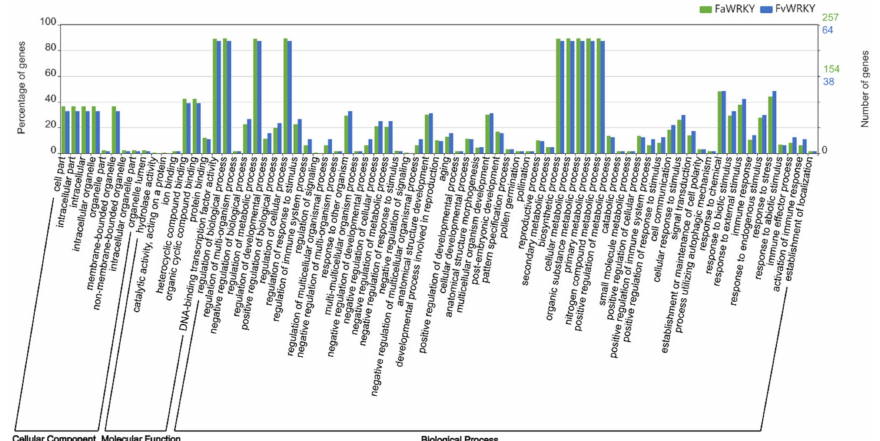
Figure 6. GO functional annotation plot comparing the number and percentage of FvWRKY and FaWRKY proteins sharing the same functions. The y -axis represents the number (right) and the percentage (left) of WRKY genes in Fragaria × ananassa (green) and in Fragaria vesca (blue) for each GO category ( x -axis).